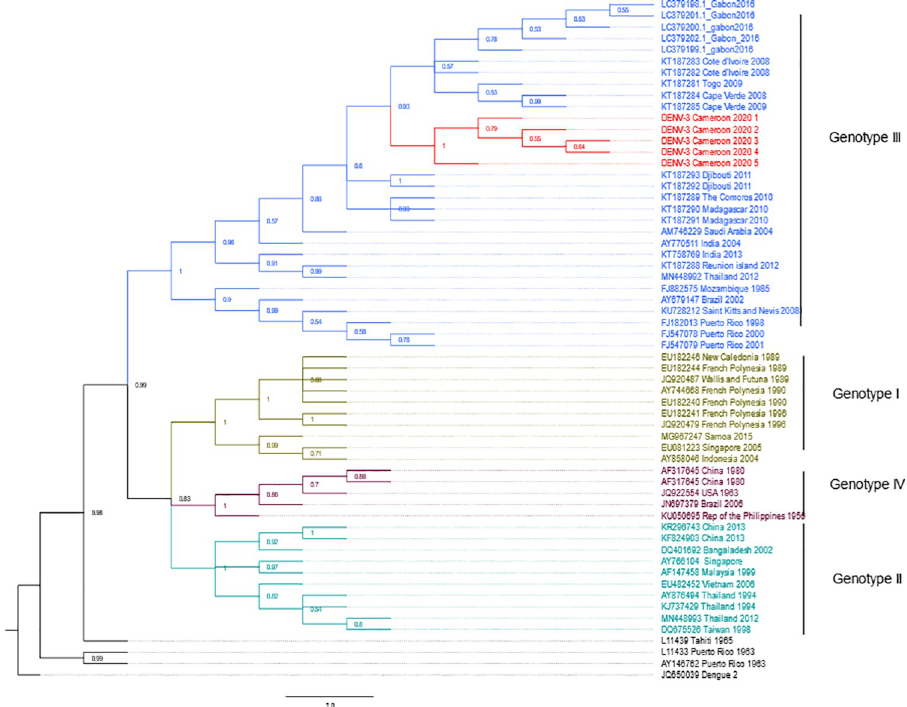
Fig 4. Dengue virus 3 phylogenetic tree built with a 1026 bp fragment of the envelope gene. The maximum likelihood tree was built using the TN-93 +G+I model. Each DENV genotype is represented by a single colour. The five sequences from this study are highlighted in red. The tree node value represented the bootstrap expressed in decimal. Dengue virus 4 from Singapore was used as outgroup. DENV-3 from Cameroon belongs to the genotype III. They share a common ancestor with the viruses active in West Africa since